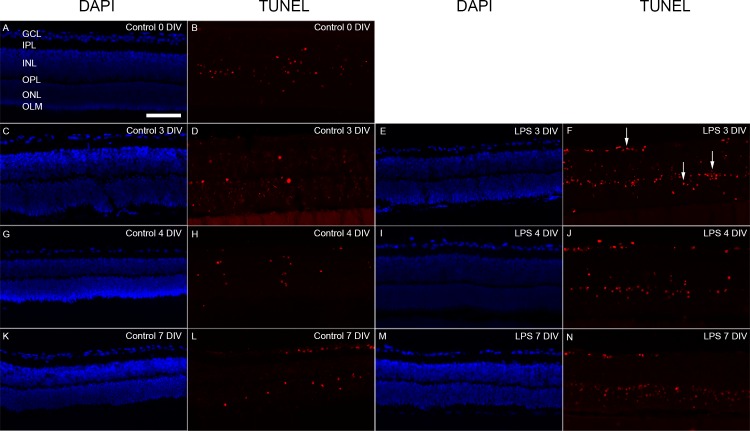
Apoptotic cell death detected with TUNEL staining.At 0 DIV, apoptotic cells (TUNEL-positive (red)) were primarily found in the INL (A, B). Nuclei were labelled with DAPI (blue). Over time in culture, moderate number of TUNEL-positive cells was seen in the non-treated group, in all nuclear layers, the GCL, INL and ONL (D, H, and L). In the corresponding age-matched LPS exposed groups, larger numbers of TUNEL-positive cells were found, especially at 3 DIV (F, arrows). Abundant numbers of TUNEL-labelled cells were also found at 4 and 7 DIV (J and N, respectively). GCL = ganglion cell layer, IPL = inner plexiform layer, INL = inner nuclear layer, OPL = outer plexiform layer, ONL = outer nuclear layer, OLM = outer limiting membrane. Scale bar: 200 μm.